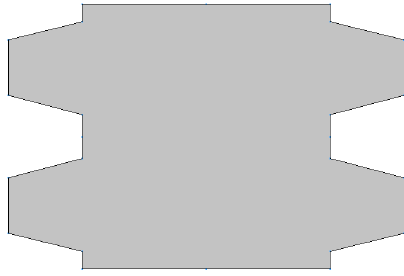
Figure 3: Profile of the geometry experimentally investigated by Sumali